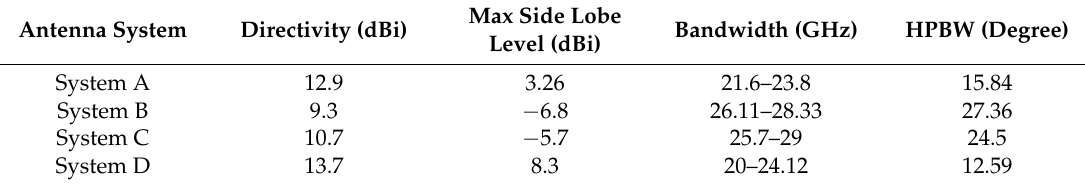
Table 3. Directivity, maximum side lobe level, bandwidth, and HPBW of the four antenna systems in their mid-band frequency ranges. System A. Vivaldi antenna array with three-way SIW power divider. System B: Vivaldi antenna array with two-way 180 degrees SIW power divider. System C: Vivaldi antenna array with two-way 120 degrees SIW power divider. System D: Vivaldi antenna array with four-way SIW power